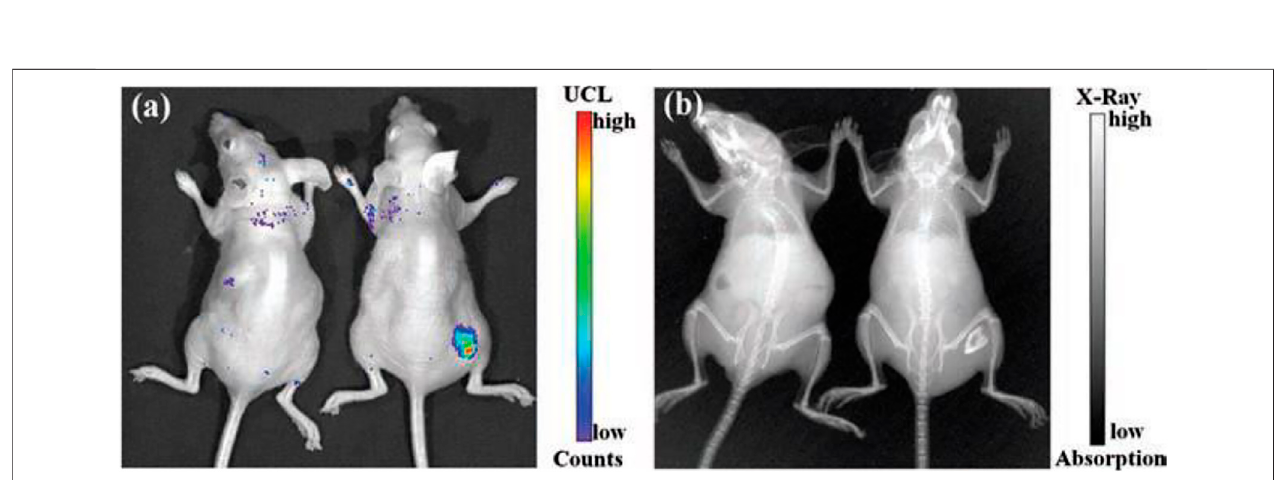
FIGURE10| Invivo upconversionluminescenceimages (A) andX-rayimaging (B) ofmiceaftersubcutaneousinjection(left)withoutand(right)withNaGdF 4 :Yb,Er (He et al., 2011a).